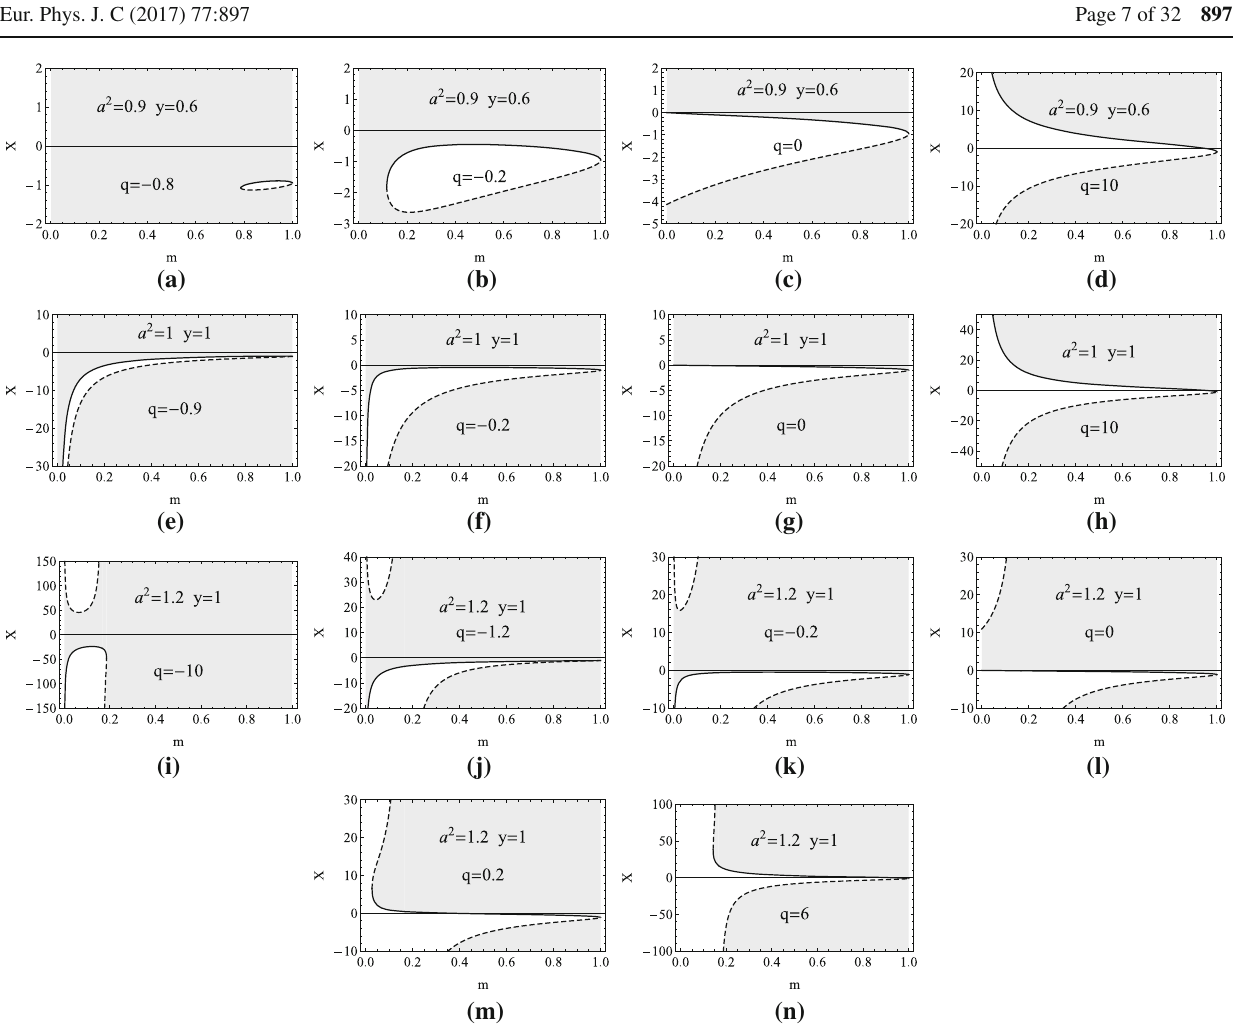
(middle row), y > 1 / a 2 (bottom row), and with q representing signifi- cant cases q < 0 , q = 0 , q > 0 . Shading demarcates the region where the latitudinal motion is